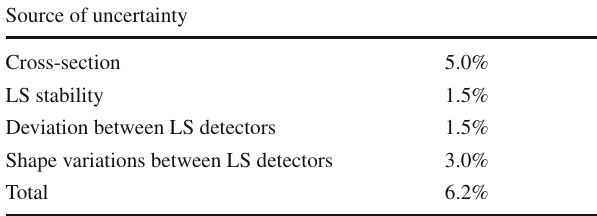
Table2 Constraintsintermsofcoincidencerateusedinthefit.Thecon- straint on the scattering cross-section reflects the discrepancies between the neutron databases. Constraints concerning the LS detectors are derived from the characterization detailed in Sect. 2.4